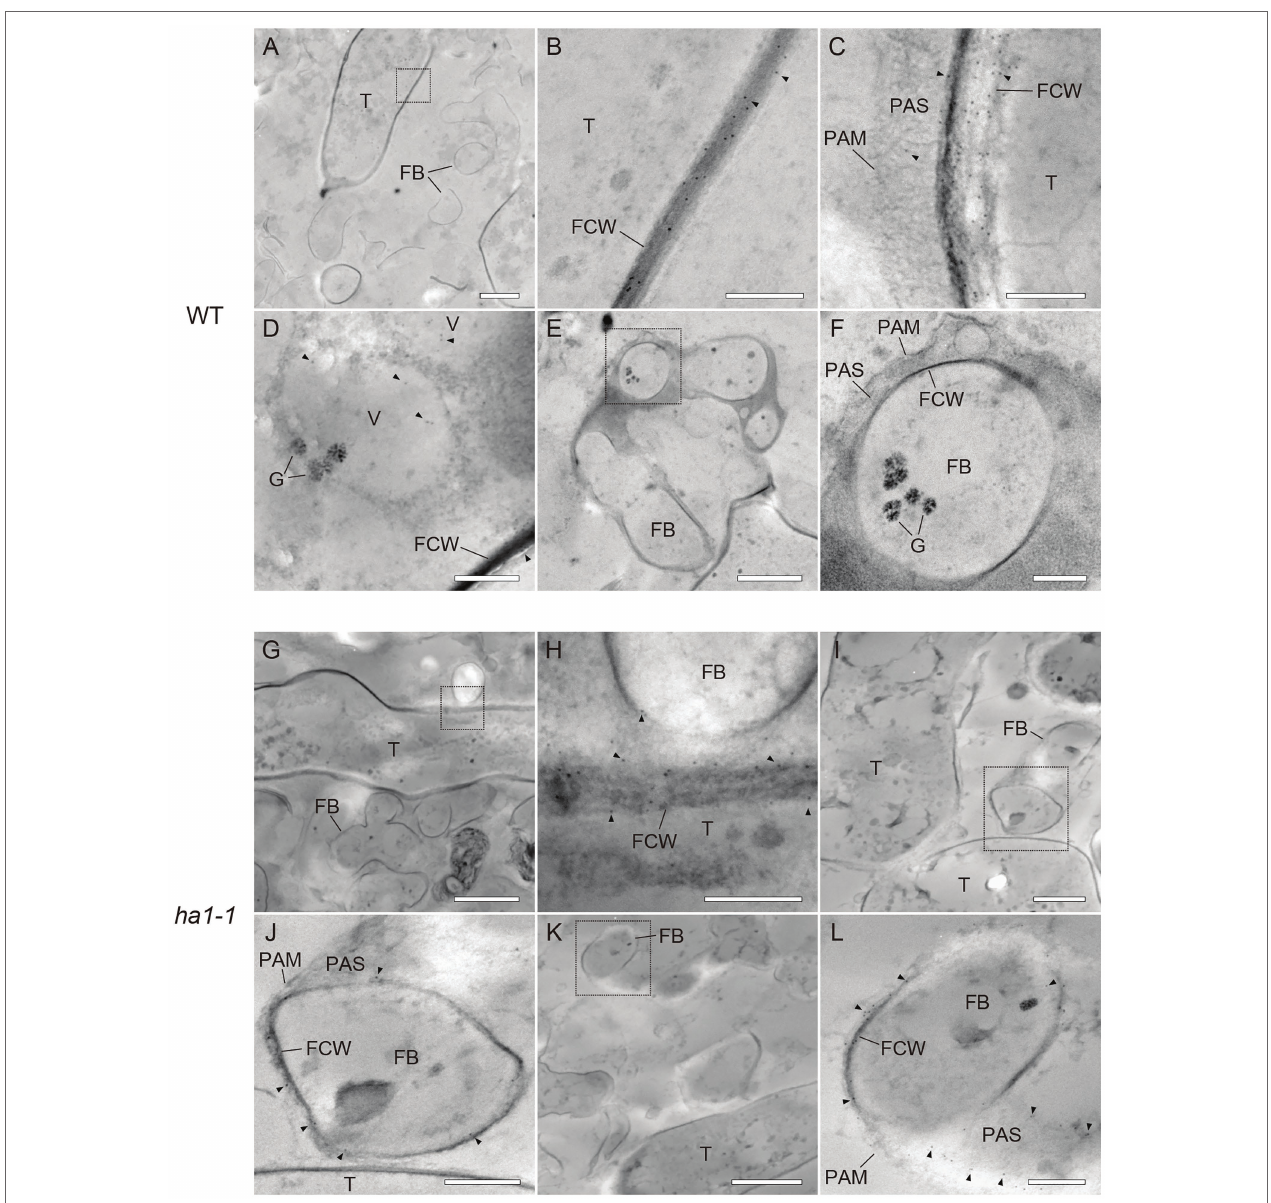
FIGURE 5 | Ultrastructural localization of polyphosphate (polyP) using polyP binding domain (PPBD) affinity labeling. Representative transmission electron micrographs showing polyP distribution (gold particle) in mycorrhizal roots of wild-type (A–F) and ha1-1 (G–L) . Sections were incubated with a PPBD-anti-Xpress antibody complex and, subsequently, an anti-mouse IgG conjugated with 6-nm colloidal gold. Triangles show representative gold particles. (A–C) PolyP present in the trunk hyphae cell wall. (D) Occasional labeling in fungal vacuoles. (E–F) Fine branches lacking signal. (G,H) Signals were often detected in the trunk hyphae cell walls in the ha1-1 roots. (I–L) Fine branch cell walls were sometimes labeled in ha1-1 . Panels (B,F,H,J,L) show the magnified images of dotted areas in the previous panels. FB, fine branch; FCW, fungal cell wall; G, glycogen granule; PAM, periarbuscular membrane; PAS, periarbuscular space; T, trunk hypha; and V, vacuole. Scale bars = 500